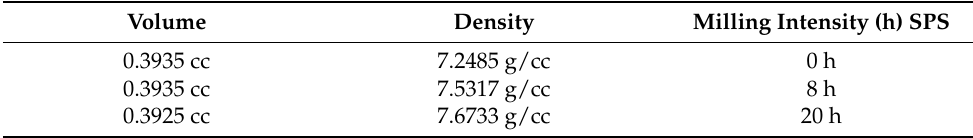
Table 1. Density of milling samples with Cr 2 Nb powders 1 .